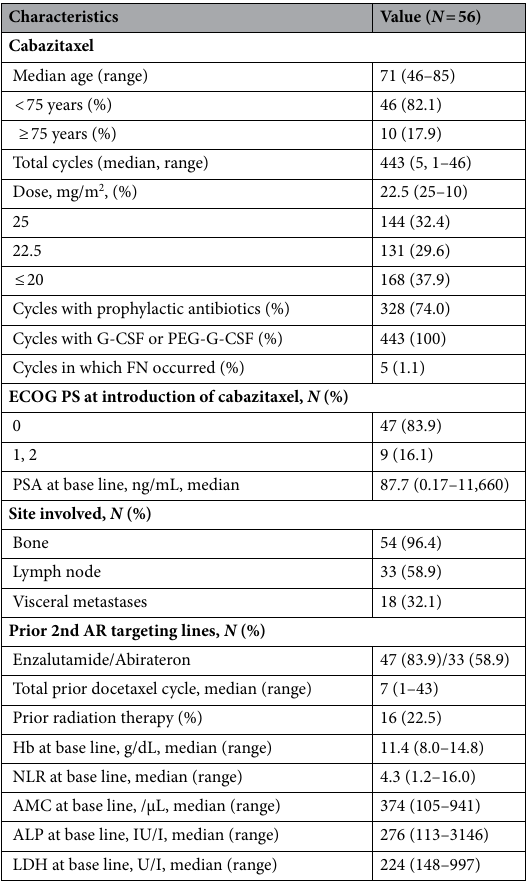
Table 1. Characteristics of patients treated with cabazitaxel. G-CSF, granulocyte-colony stimulating factor; PEG-G-CSF, polyethylene glycol-granulocyte-colony stimulating factor; FN, febrile neutropenia; ECOG PS, Eastern Cooperative Oncology Group performance status; PSA, prostate-specific antigen; AR, androgen receptor; Hb, hemoglobin; NLR, Neutrophil to Lymphocyte ratio; AMC, absolute monocyte count; ALP, alkaline phosphatase; LDH, lactate